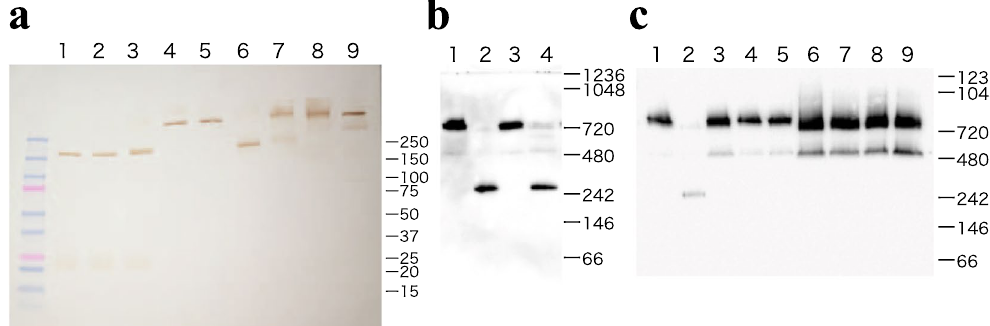
Figure 1. Molecular form of circulating α 2 -macroglobulin molecules in humans. ( a ) Representative SDS- PAGE under reducing and non-reducing conditions of purified human α 2 -macroglobulin protein and human serum. Ten-microliters of fresh human serum diluted to 1:80 and pretreated with 25 mM (lane 1), 10 mM (lane 2), 1 mM (lane 3), 0.1 mM (lane 4), or 0.01 mM of DTT (lane 5), 0.5 µ g of purified α 2 -macroglobulin protein pretreated with 25 mM (lane 6) or 0.1 mM of DTT (lane 7), and 10 µ L of fresh human serum diluted to 1:80 and pretreated with (lane 8) or without 0.5% SDS (lane 9) were subjected to 4–20% gradient gel electrophoresis and immunoblotted using human α 2 -macroglobulin antibody. ( b ) BN-PAGE of human serum and purified α 2 - macroglobulin protein pretreated with and without DTT. Purified α 2 -macroglobulin protein (0.1 µ g) pretreated without (lane 1) or with 25 mM of DTT (lane 2) and 10 μ L of fresh human serum diluted to 1:400 pretreated without (lane 3) or with 25 mM of DTT (lane 4) were subjected to BN-PAGE and subsequent immunoblotting using human α 2 -macroglobulin antibody. ( c ) BN-PAGE of purified α 2 -macroglobulin protein and diluted sera and subsequent immunoblotting using human α 2 -macroglobulin antibody. Purified α 2 -macroglobulin (0.05 μ g) protein pretreated without (lane 1) or with 25 mM of DTT (lane 2), and 10 µ L of diluted sera (1:400) obtained from 3 healthy volunteers (lane 3–5) and 4 patients with diabetes (lane 6–9) showing increased α 2 - macroglobulin concentrations were subjected to BN-PAGE and subsequent immunoblotting. The figure shows the cropped blots and the full-length blots are presented in Supplementary Fig.